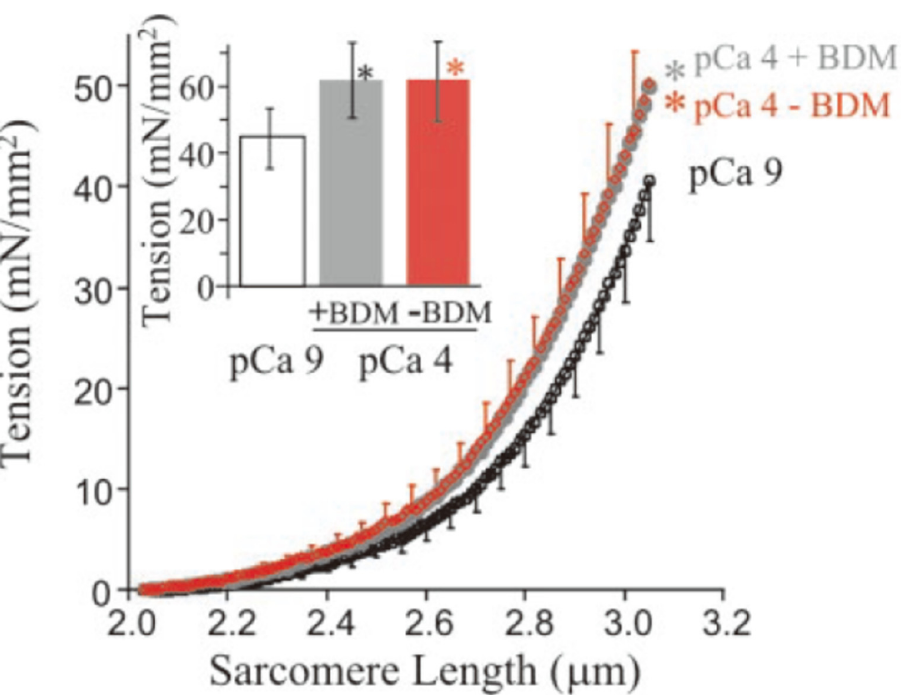
Figure 7. Increased passive force by adding Ca 2+ [48]. The passive force in the skinned fibers (mainly derived from titin) was increased by adding Ca 2+ (pCa4.0). This enhancement was not different although the cross-bridge cycling was inhibited by adding 2,3-butanedione monoxime (BDM), indicating that this enhanced force was caused by Ca 2+ . (Copyright (2003) National Academy of Sciences).